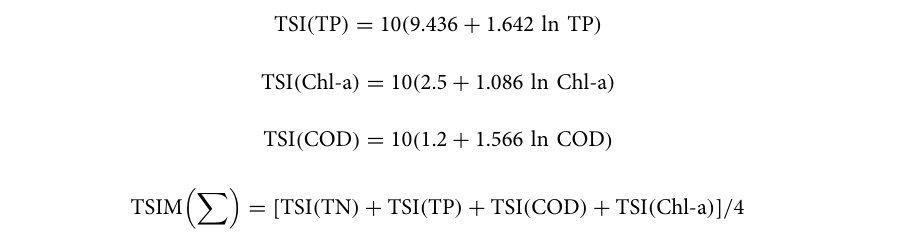
Figure 2. The spatial distribution of Trophic State Index in study period. ( a ) Rainy season (July 2017); ( b ) Dry season (October 2017); ( c ) Rainy season (July 2018); ( d ) Dry season (October 2018). The interpolation map was constructed by ArcGIS software using the Inverse Distance Weighting method. The maps were created using software ArcGIS Desktop v10.2 (www.arcgi